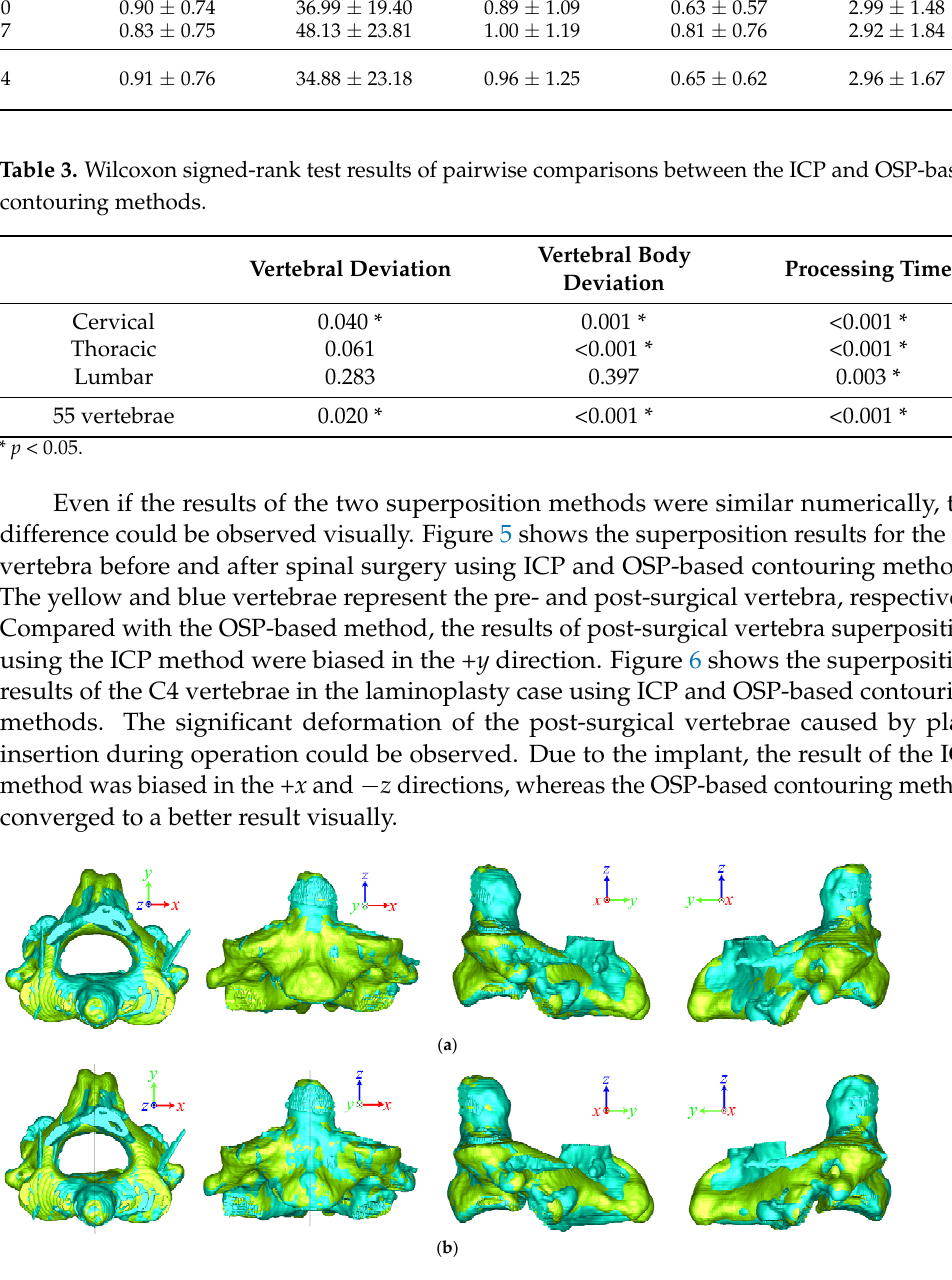
Figure 5. Superposition comparison of the ( a ) ICP and ( b ) OSP-based contouring methods for a pre- and post-surgical C2 vertebra in the pedicle screw fixation case.